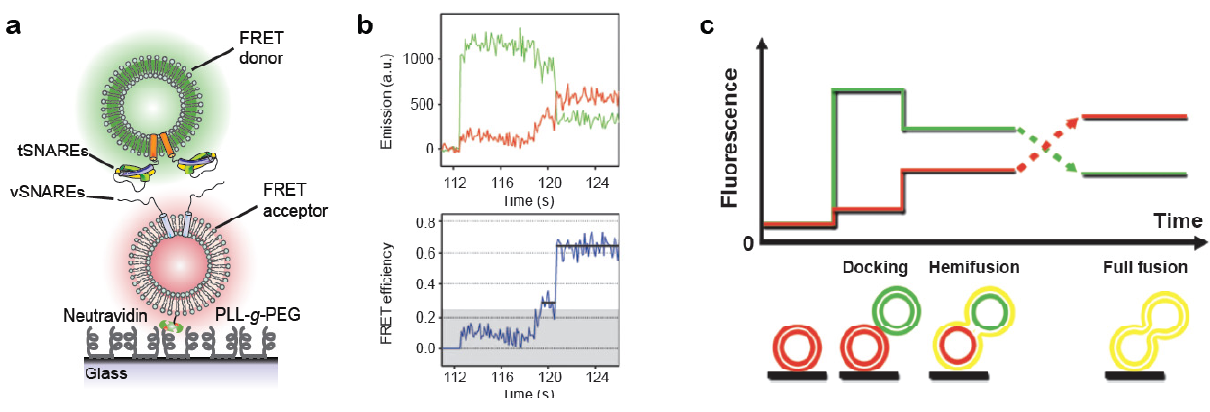
Figure 6. Single vesicle-vesicle fusion assay. (a) A population of vesicles carrying reconstituted vSNAREs is tethered to a solid support through biotin-neutravidin coupling and allowed to interact with a freely diffusing population of vesicles harbouring cognate tSNAREs. The surface is passivated with PLL- g -PEG to prevent non-specific interactions of the tSNARE vesicles and the surface. (b) Discrete steps of docking, hemifusion and full fusion as evidenced from the apparent FRET efficiency (bottom) calculated from donor (green) and acceptor (red) emission during fusion of a single vesicle pair. The abrupt increase in donor emission in the beginning of the trace marks vesicle docking. (c) Simplified sketch of the evolution of donor and acceptor emission and the configurations thought to be associated with each level of FRET. Figures (b,c) were adapted from [56], Copyright 2006 National Academy of Sciences,